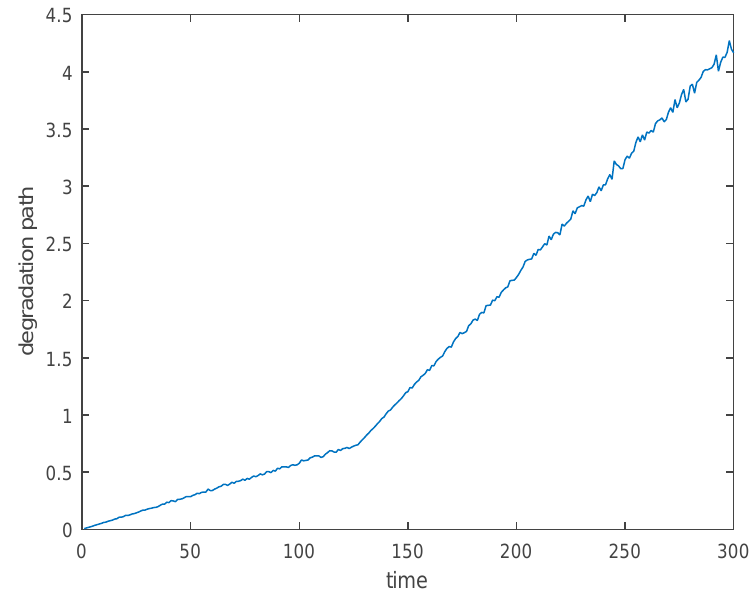
Figure 6. Created degradation path.